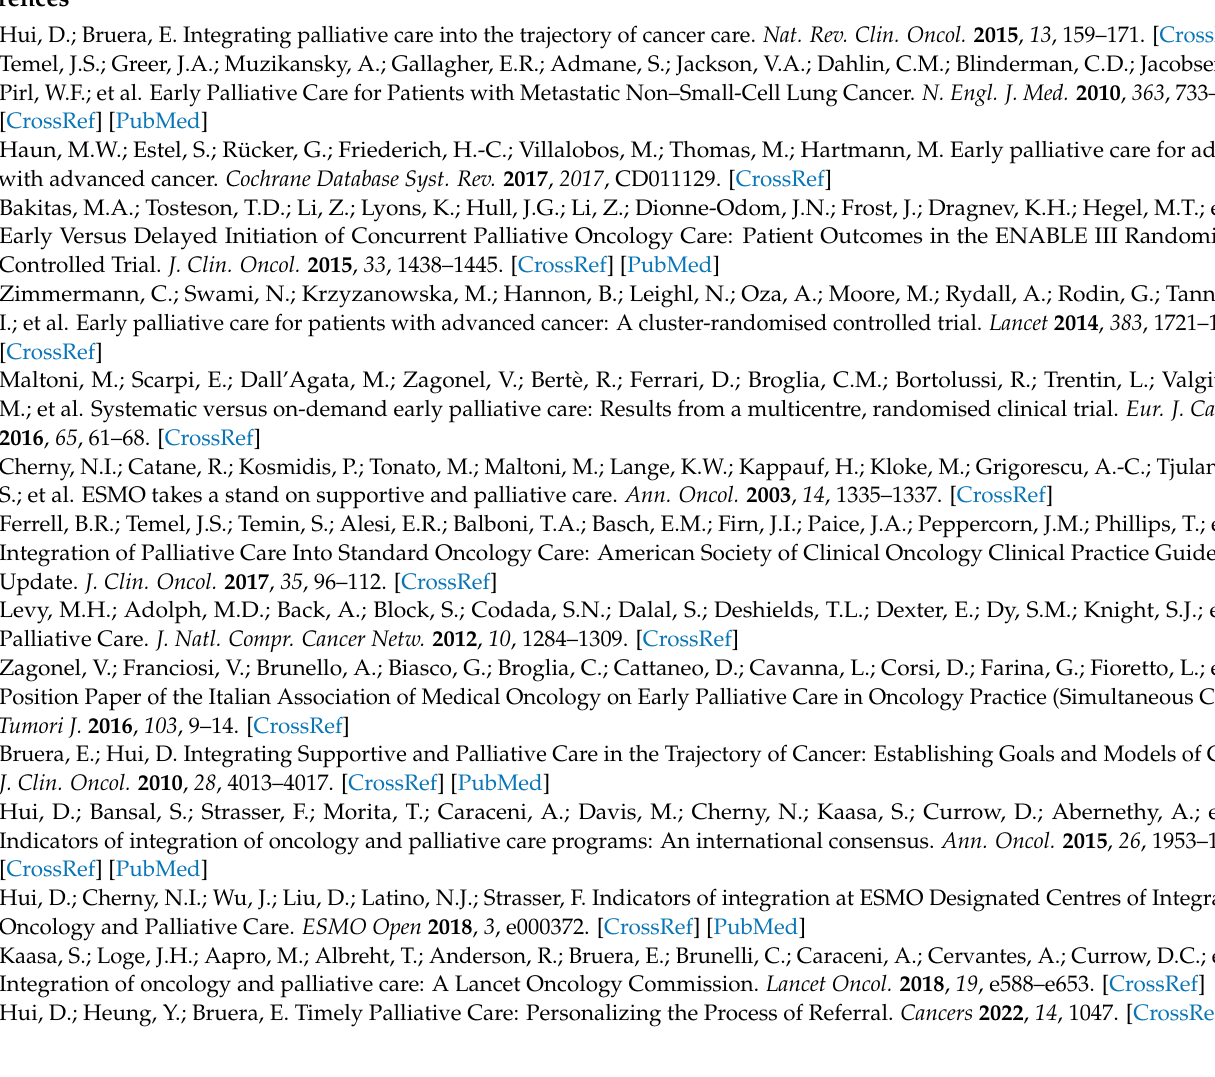
Figure A3. Symptom severity among patients, according to ESAS. Bars represent the absolute frequencies of symptoms grouped by three levels of severity. The number of patients for whom individual ESAS scores were available ranged from 661 to 675.